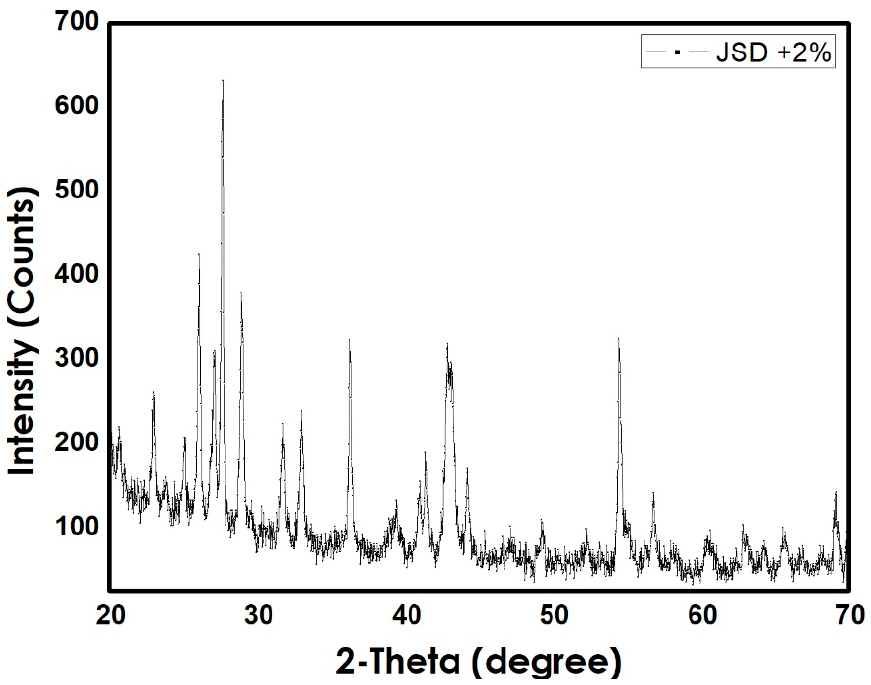
Figure 4. XRD pattern for JSD + 2% Fe 3 O 4 composite .